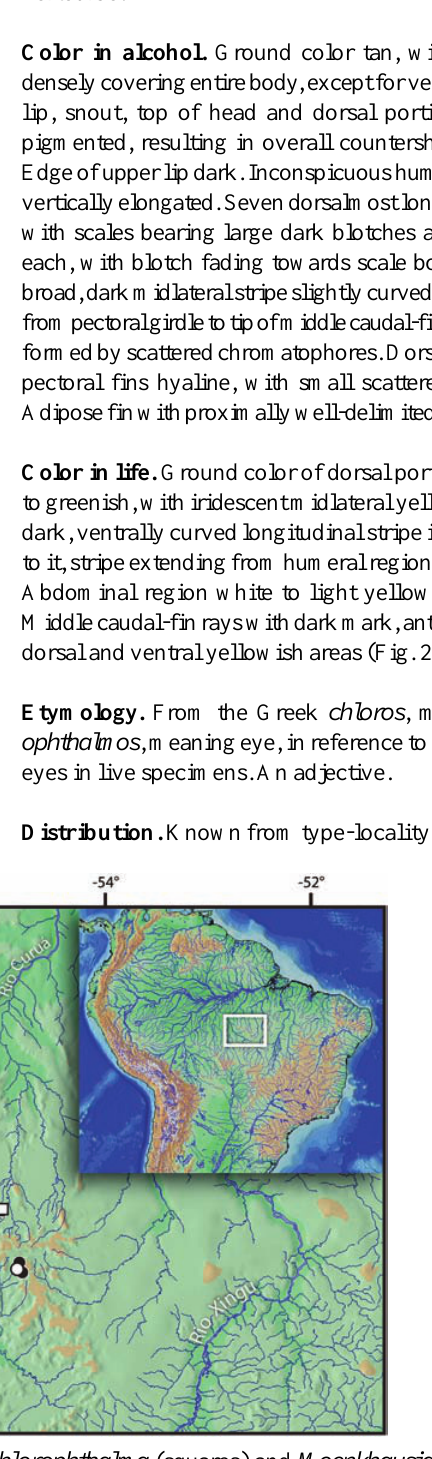
spine of 17 th (2) vertebra. Caudal-fin forked, lobes slightly rounded, similar in size. Principal caudal-fin rays i,9+8,i. Dorsal procurrent caudal-fin rays 13(2) and ventral procurrent caudal-fin rays 9(1) or 11(1). Total vertebrae 34(1) or 35(1), with 16(1) or 17(1) precaudal and 18(2) caudal vertebrae.